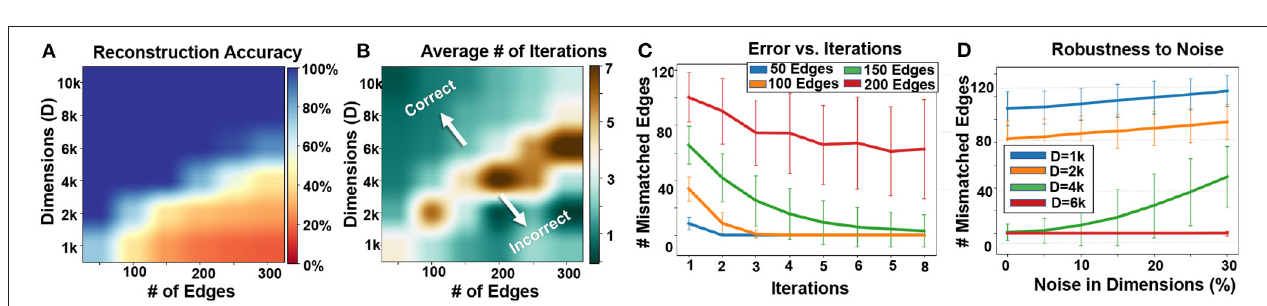
FIGURE 10 | Graph reconstruction: (A) reconstruction accuracy, (B) required iterations vs. graph size and dimensions, (C) error rate v. iterations, and (D) robustness to noise (Shown over 1,000